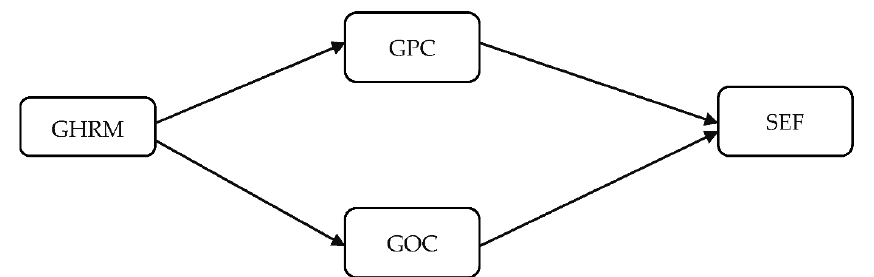
Figure 1. Conceptual model.